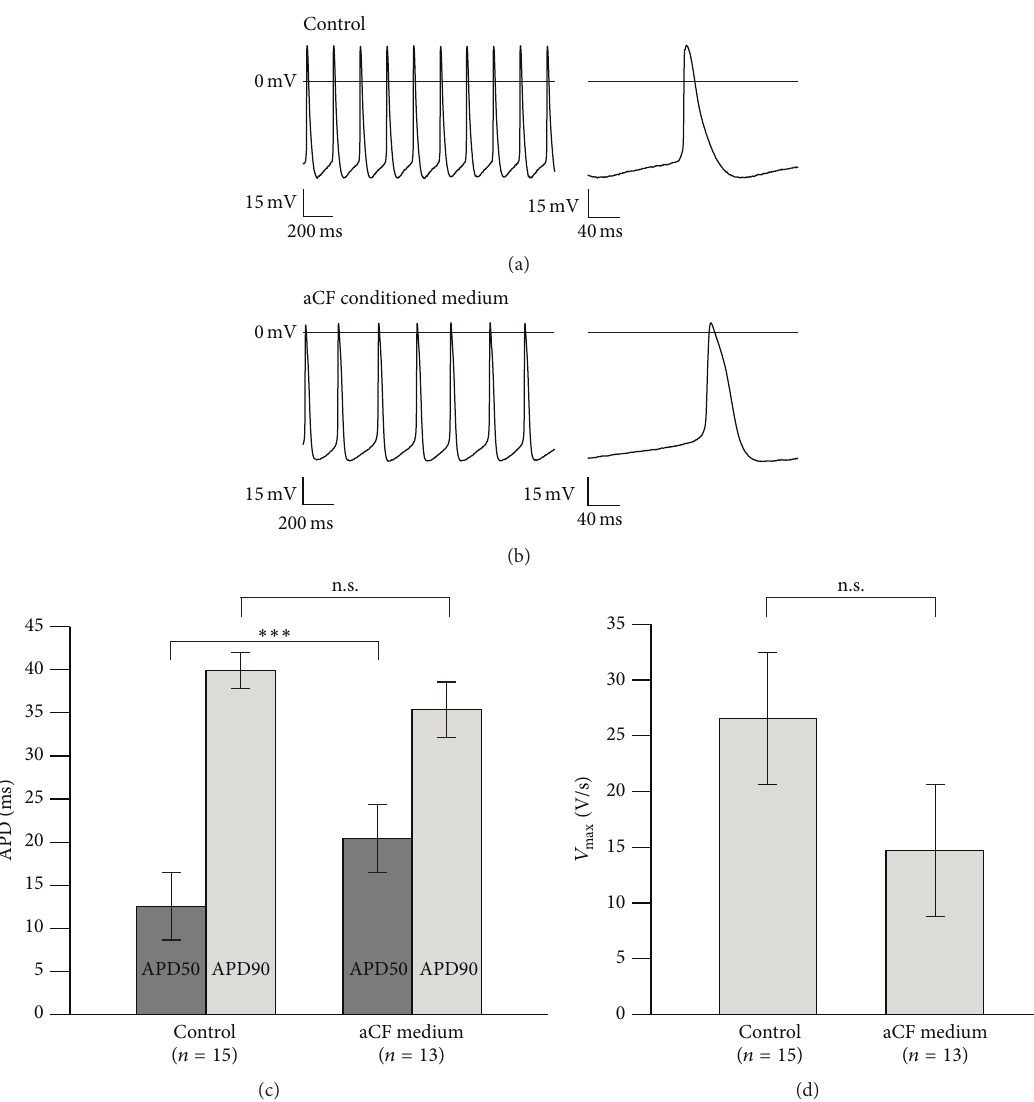
Figure 5: Effects of aCF-conditioned medium on action potential recordings of ESC-CMs. Representative AP waveforms of ESC-CM beating clusters cultured for 48 h in control medium (a) and aCF-conditioned medium (b). APD50 was prolonged (c). Maximal upstroke velocity ( 𝑉 max ) was not significantly reduced (d). Data are expressed as mean ± SEM; ∗∗∗ 𝑝 < 0.001